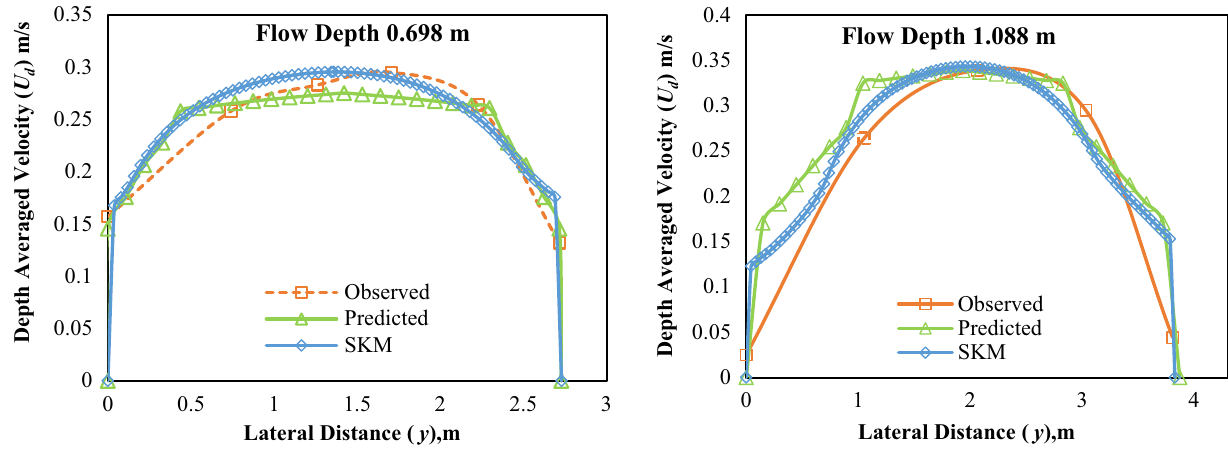
Fig. 21 Depth-averaged velocity of river Senggi